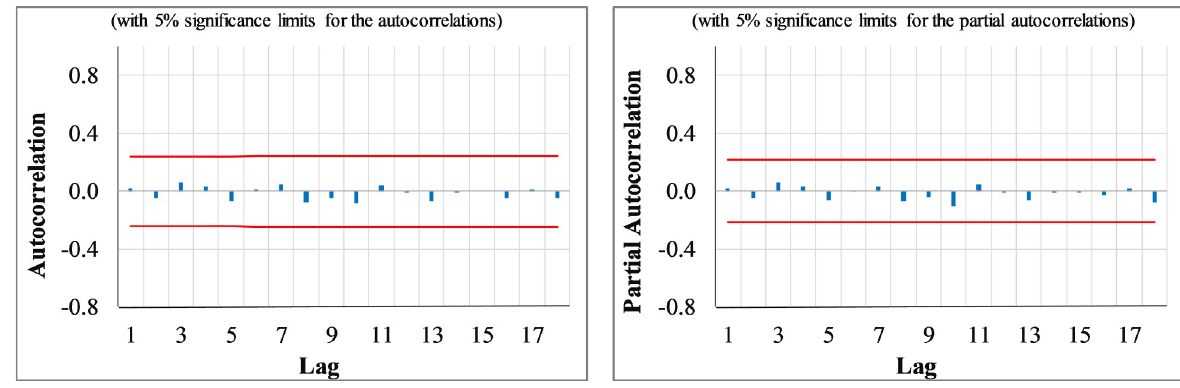
Fig 3. The ACF and PACF plots of the residuals of the ARIMA (2,0,0) intercity traffic prediction